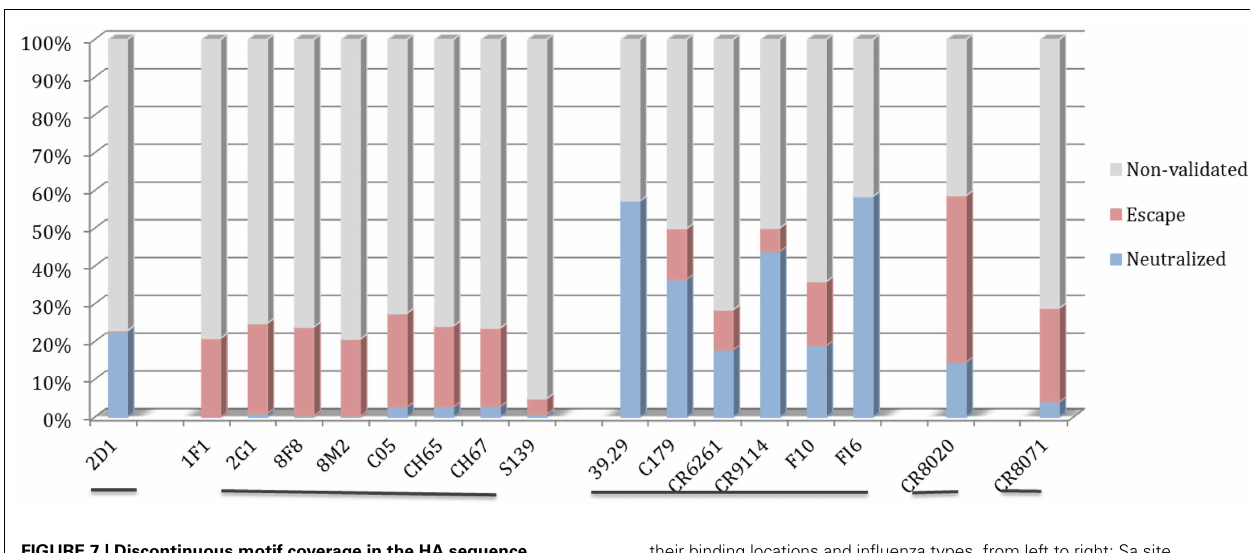
FIGURE 7 | Discontinuous motif coverage in the HA sequence dataset for cross-reactive nAbs . Only the coverage data for cross-reactive nAbs are shown here.The nAbs are grouped based on